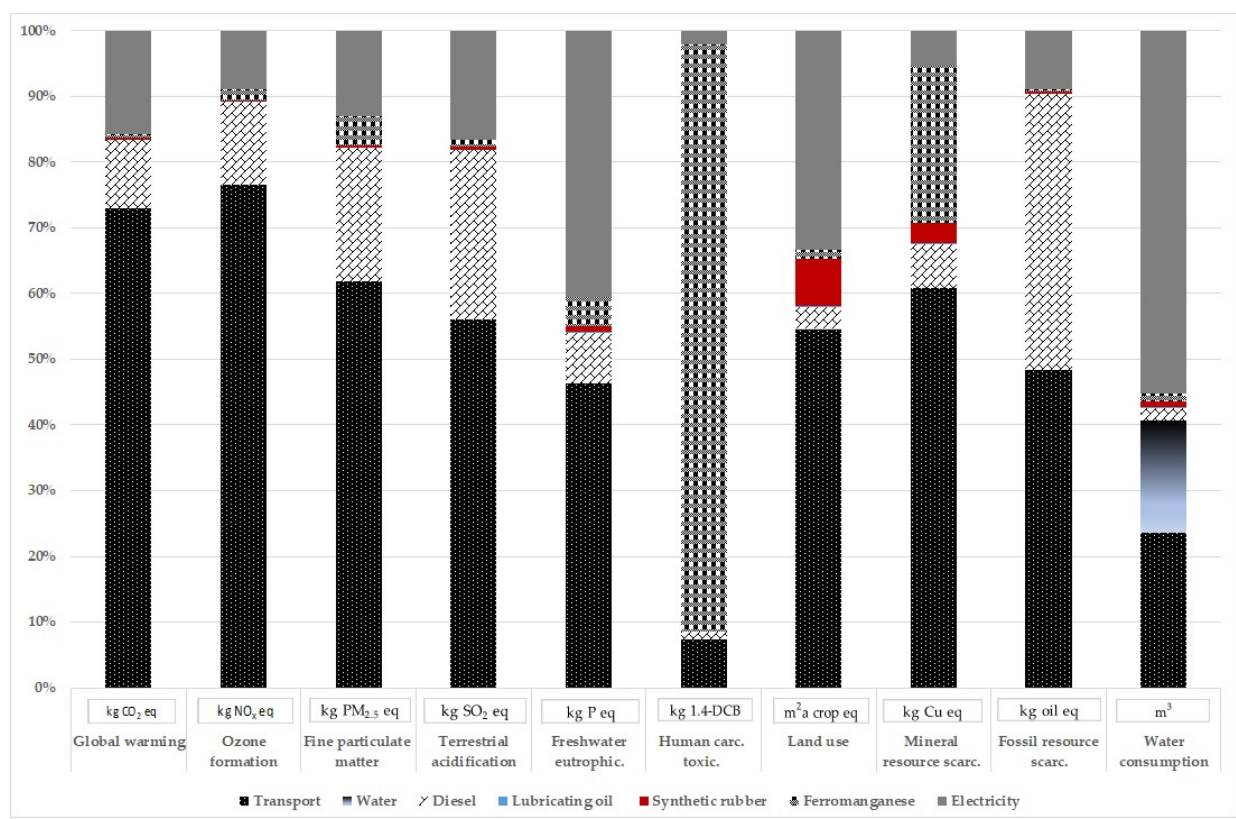
Figure 6. Percentage values of environmental induced impacts coming from the collection and recycling of 1 tonne of C&DW (from Table 5).